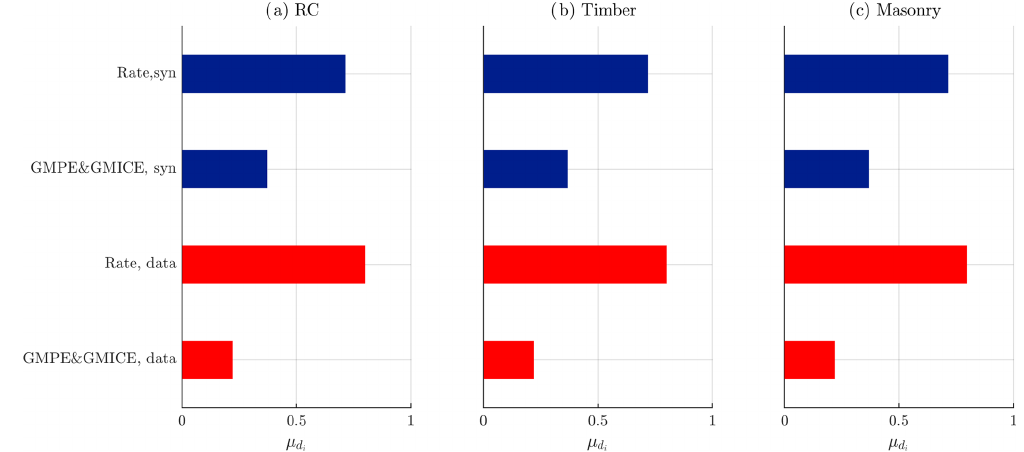
Figure 10. Sensitivity analysis of IR (observe that the QoI is logIR) based on the sensitivity measure µ d